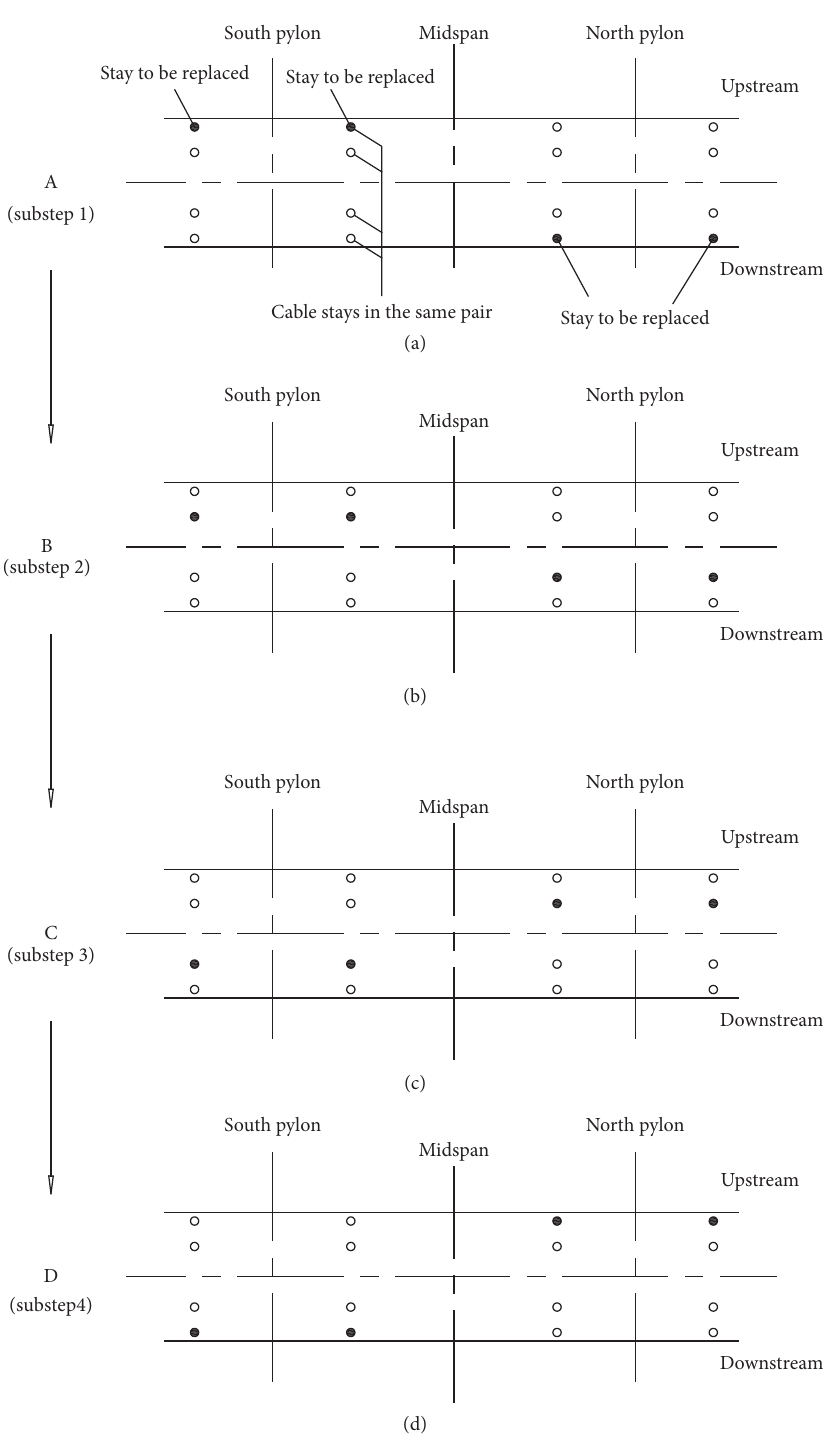
Figure 8: Schematic of cable replacement construction sequences for each load